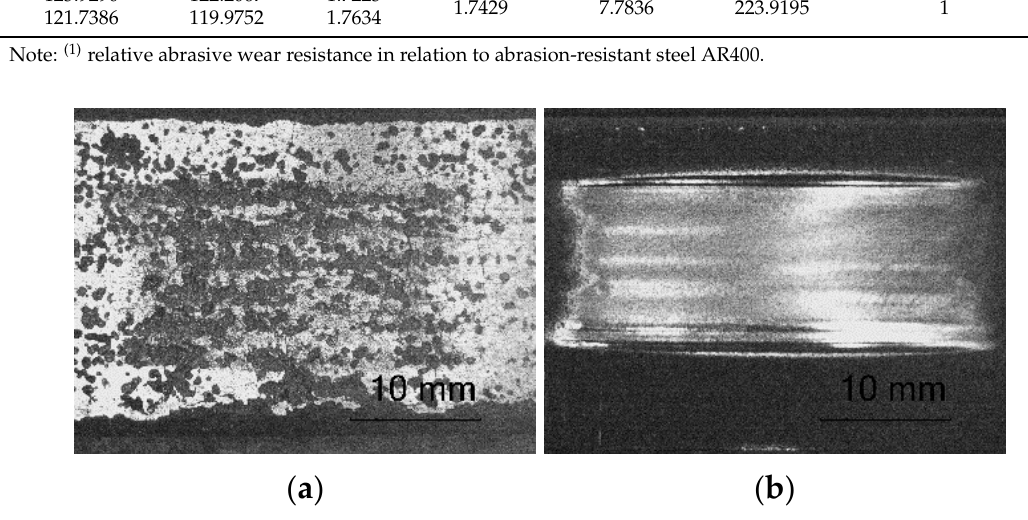
Figure 15. Surface of the composite layer and the surface of abrasion-resistant steel AR400 after